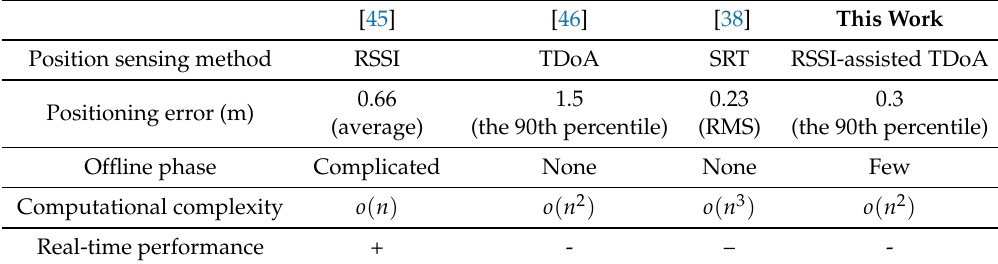
Table 1. Performance summary and